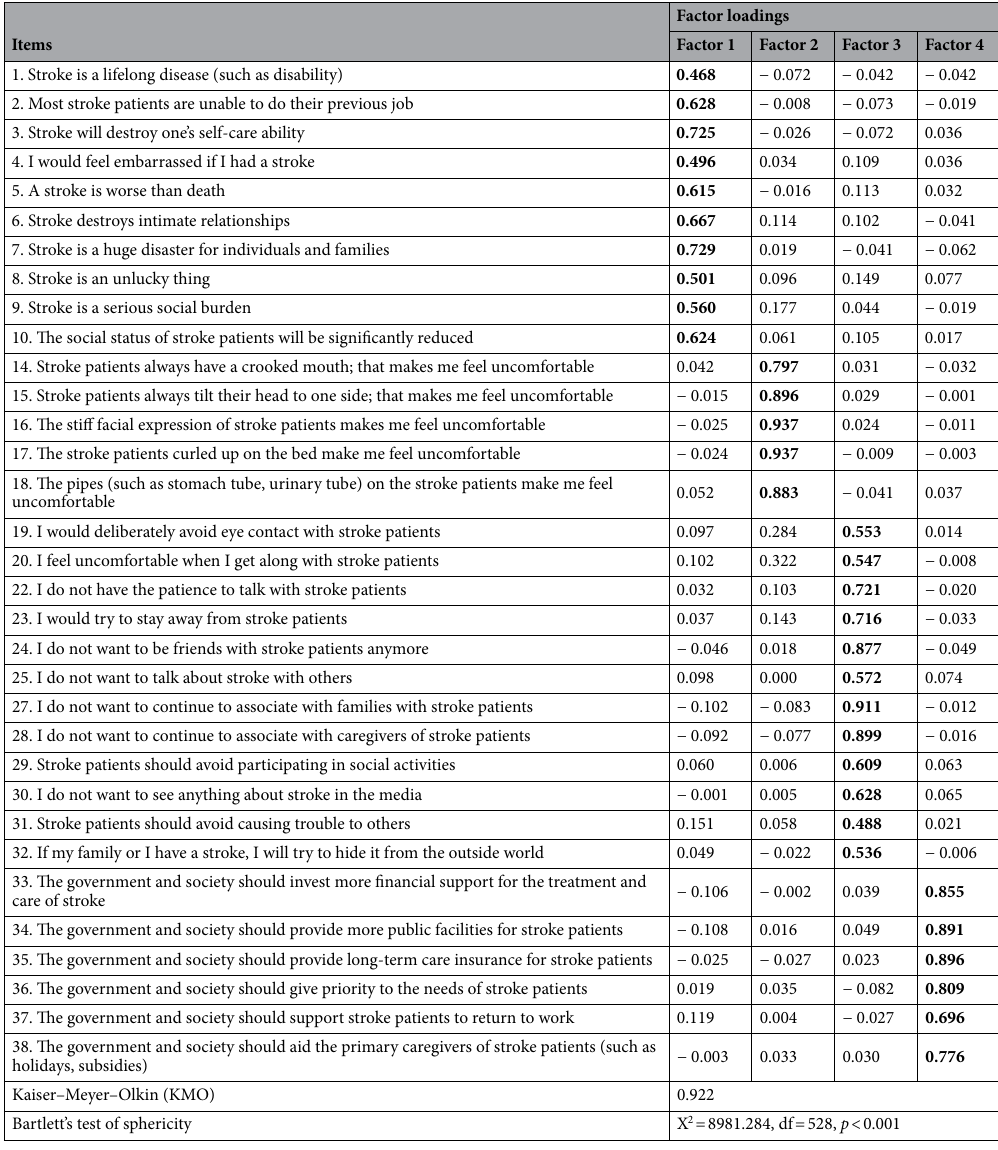
Table 2. Exploratory factor analysis with the extraction of four factors (N = 380). Factor 1, inherent ideology; Factor 2, aesthetic feelings; Factor 3, avoidance behaviour; Factor 4, policy attitudes. Factor loading > 0.4.